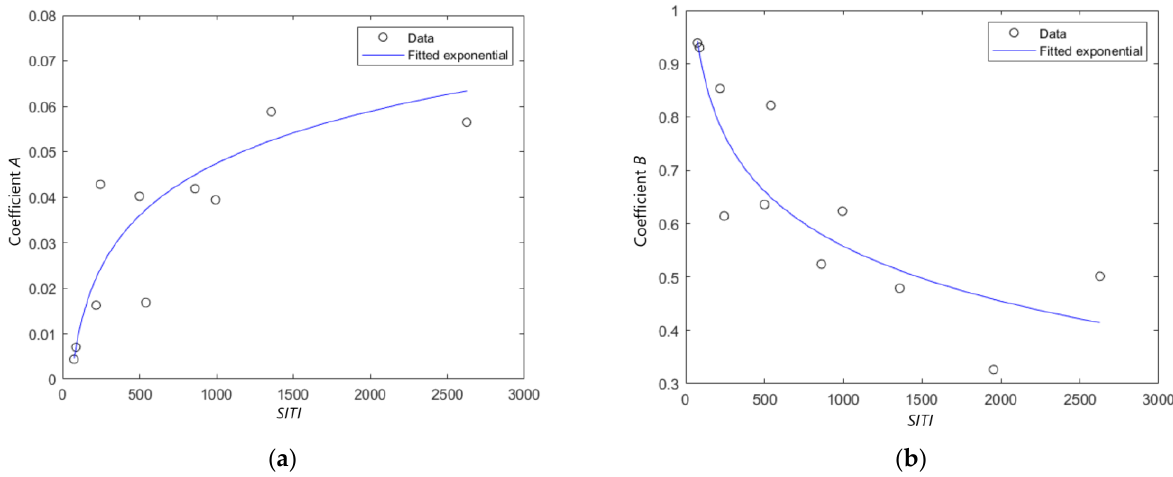
Figure 6. Fitted curves of data points presenting the functional relationship ( a ) coefficient A and SITI and ( b ) coefficient B and SITI .